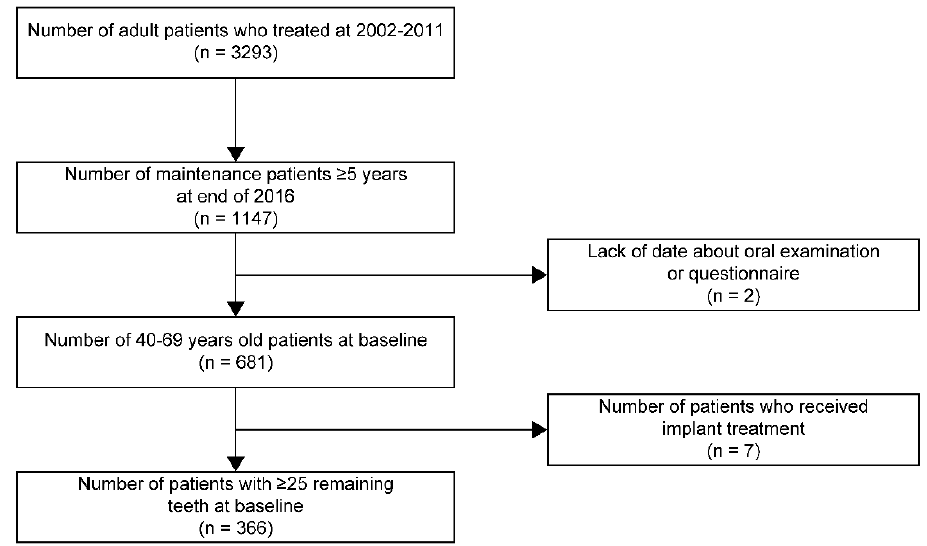
Figure 1. Flowchart of patients selection.